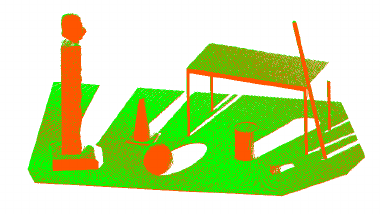
Figure 13: Coarse registration results of the pair of point clouds